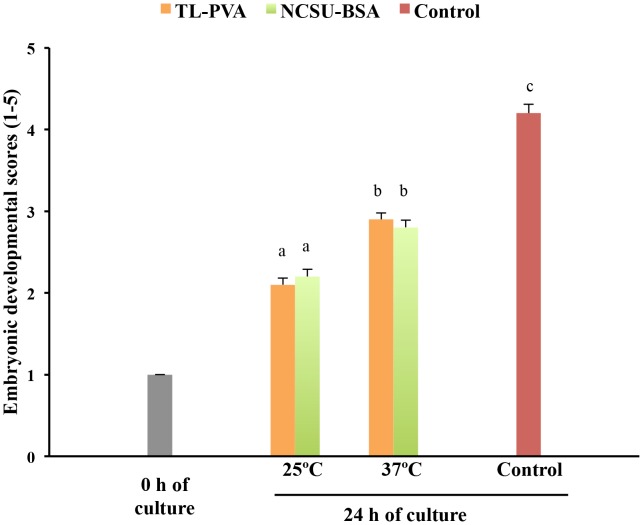
Developmental scores (means ± S.E.M.) of in vivo-derived morulae cultured for 24 h using different temperatures and media.Morulae were cultured in closed Eppendorf tubes containing 1.5 mL of TL-PVA or NCSU23-BSA media, supplemented with 10 mM HEPES, at 25°C or 37°C. Controls were morulae cultured in 4-well multi-dish plates, with each well containing 500 µL of NCSU-23 medium supplemented with BSA and fetal calf serum at 38.5°C in humidified air with 5% CO2. The developmental stage was scored according to the following classes: 1, morula; 2, early blastocyst; 3, full blastocyst; 4, expanded blastocyst; and 5, hatching or hatched blastocyst. Different letters represent differences (p<0.001) in developmental scores among groups.